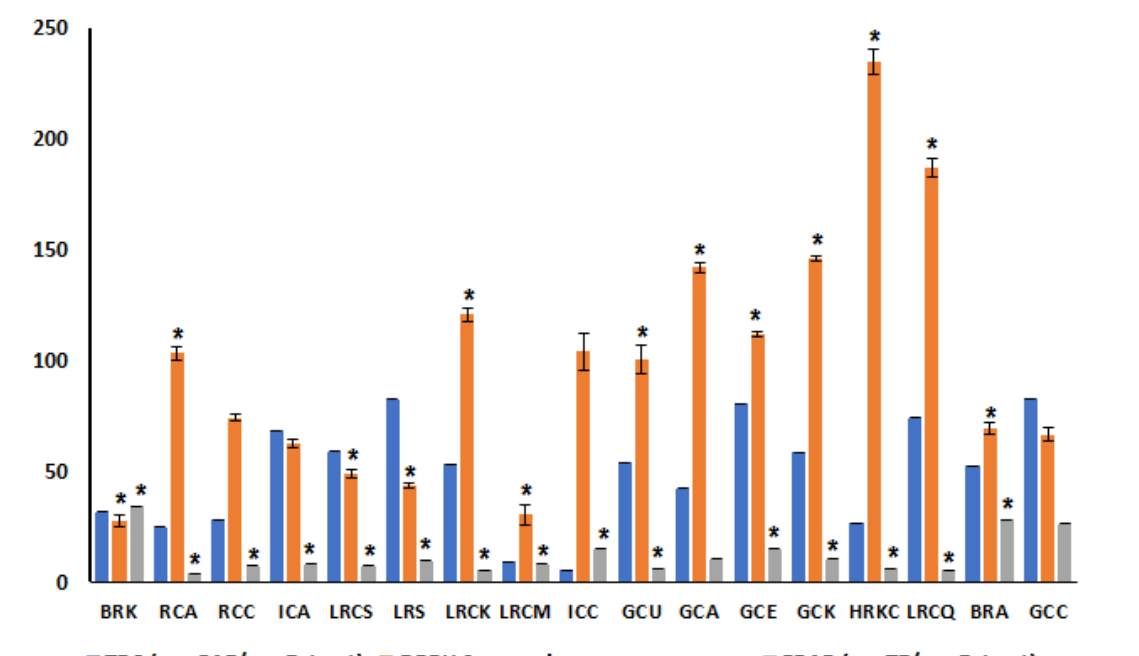
Figure 4. Total phenolic content (TPC) of the investigated coffee specimens with values expressed as mg gallic acid equivalent/g extract (mg GAE/g extract), DPPH (2,2-diphenyl-1-picrylhydrazyl) scavenging activity with values in IC 50 ± SD ( μ g/mL), and ferric reducing antioxidant power (FRAP) with values expressed in mg Trolox equivalent per mg extract (mg TE/mg extract). Each bar represents mean ± SD ( n = 3); the corresponding coffee specimen codes are listed in Table 1. *: Significant values compared to GCC specimen ( p < 0.05).